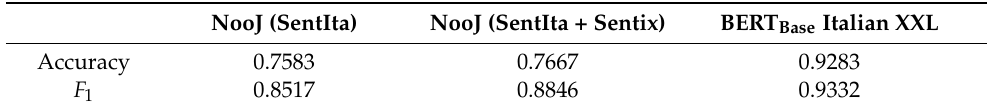
Table 5. Accuracy and Micro F 1 results.